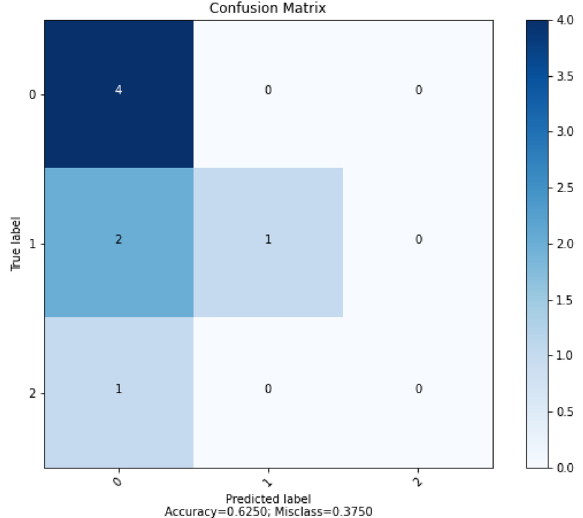
Figure 13. Confusion matrix for GD.